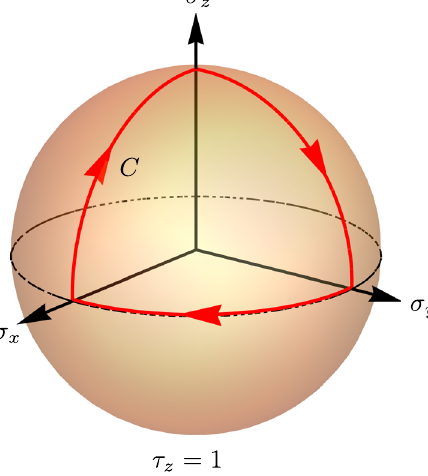
1 sector, the instantaneous eigenstates of FIG. 1. In the τ z ¼ H ð t Þ trace out an octant of the Bloch sphere, shown above as the contour C . At times t ¼ 0 , t 1 , t 2 , t , only one of the Δ is i op nonzero. At these times, σ commutes with the Hamiltonian, i and the corresponding point on the contour is one of the corners or “ turning points ” . The holonomic phase at the end of the evolution is half the solid angle traced out by the contour C , ½ Ω ð C Þ = 2 (cid:4) ¼ − ð π = 4 Þ